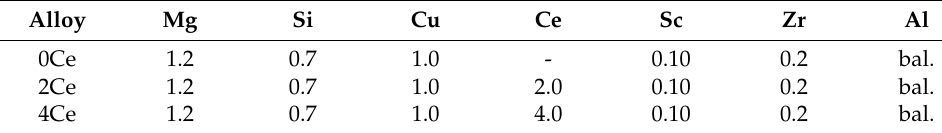
Table 1. Chemical compositions of the studied alloys (wt.%).